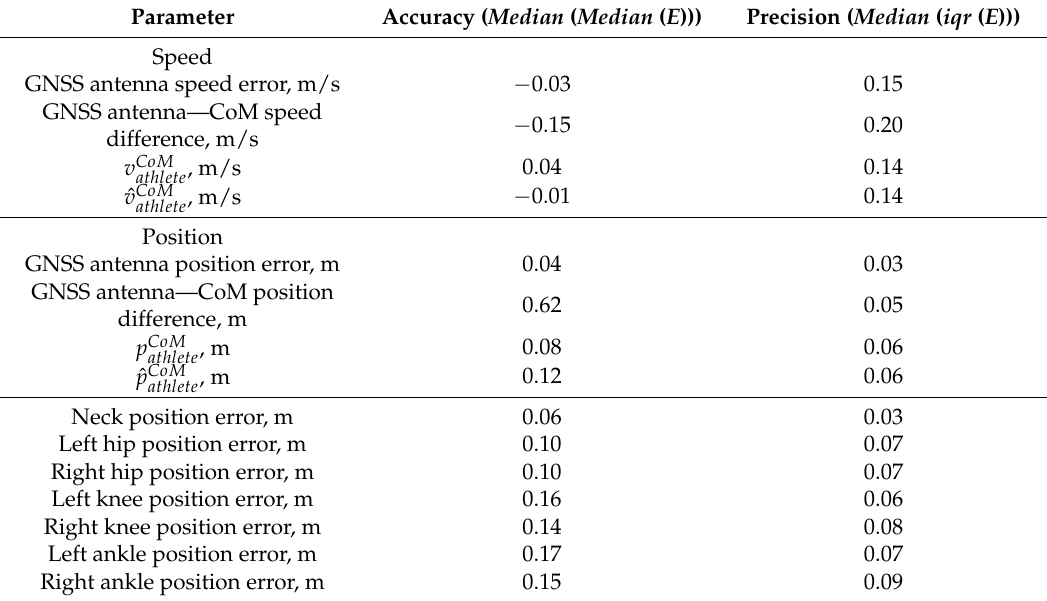
Table 1. Median accuracy and precision for all errors and differences between GNSS antenna and CoM speed and